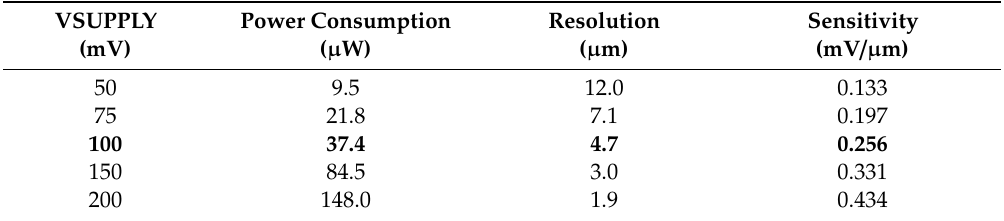
Table 1. Summary of the performance of the realized ULP-ECDS when operating in combination with the carbon steel target. The performance in the best trade-o ff condition is highlighted in bold.